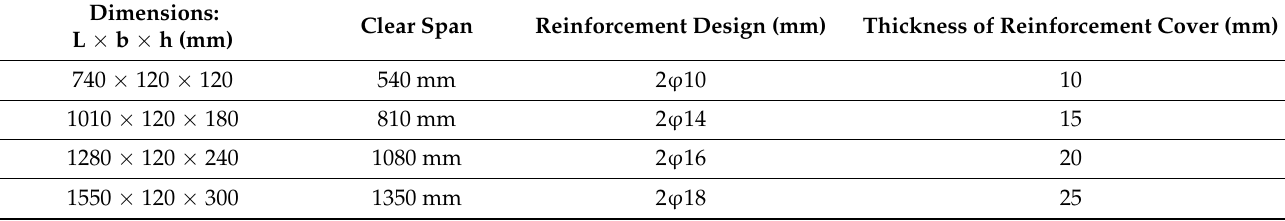
Table 5. Beam size and reinforcement design.